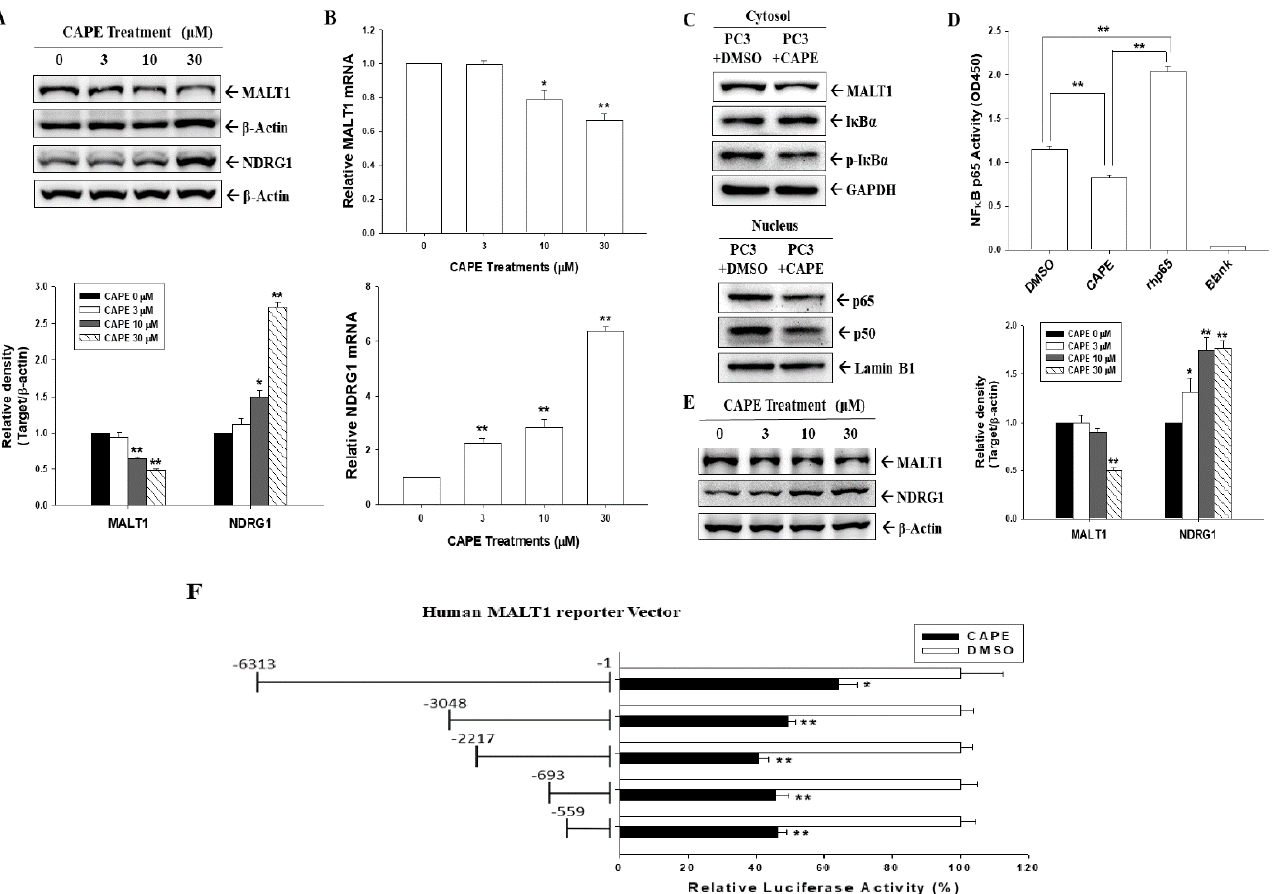
Figure 3. Effects of CAPE on NF ‐κ B activation in AR  negative PC ‐ 3 cells. ( A ) The PC ‐ 3 cells